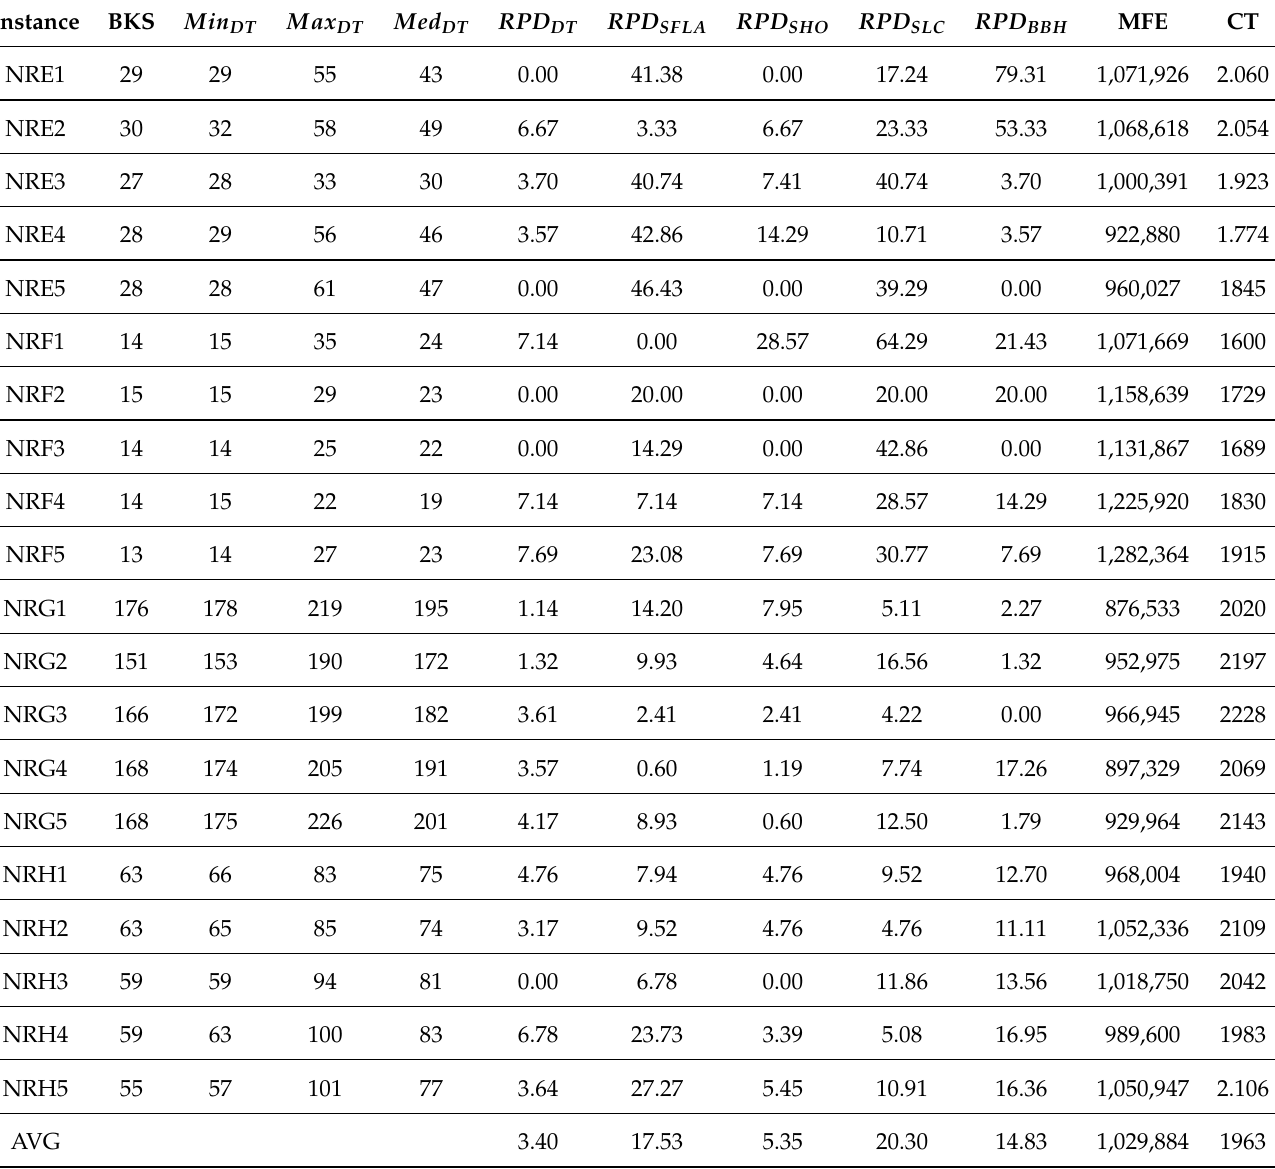
Table 3. K nodes RPD comparison for standalone and distributed